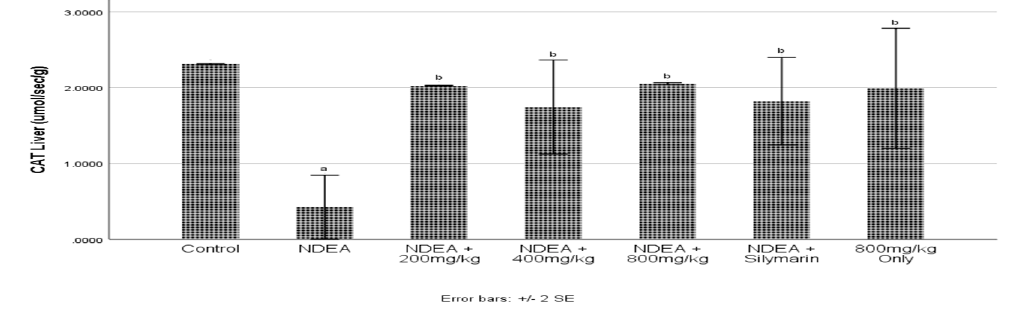
Figure 4. Effect of Cajanus cajan on catalase activity. Values are expressed as mean ± SEM; a Values differ significantly from control group; b Values differ significantly from NDEA-treated group.